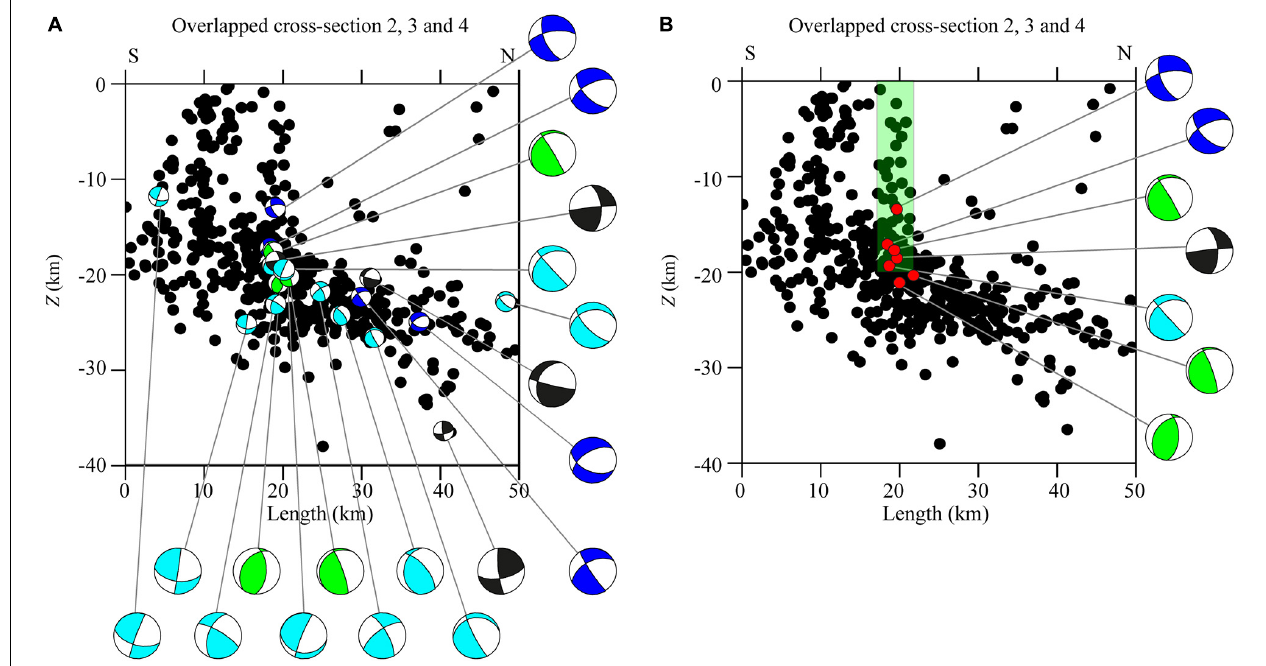
FIGURE 9 | Overlapped cross-sections 2, 3, and 4 of Figure 8 . (A) focal mechanisms are projected in cross-section. Beachball colors are as described in the Figure 5 caption. (B) A selection of focal mechanisms as described in the text with red dots indicating the hypocenters, green rectangle indicates the MF shear zone.